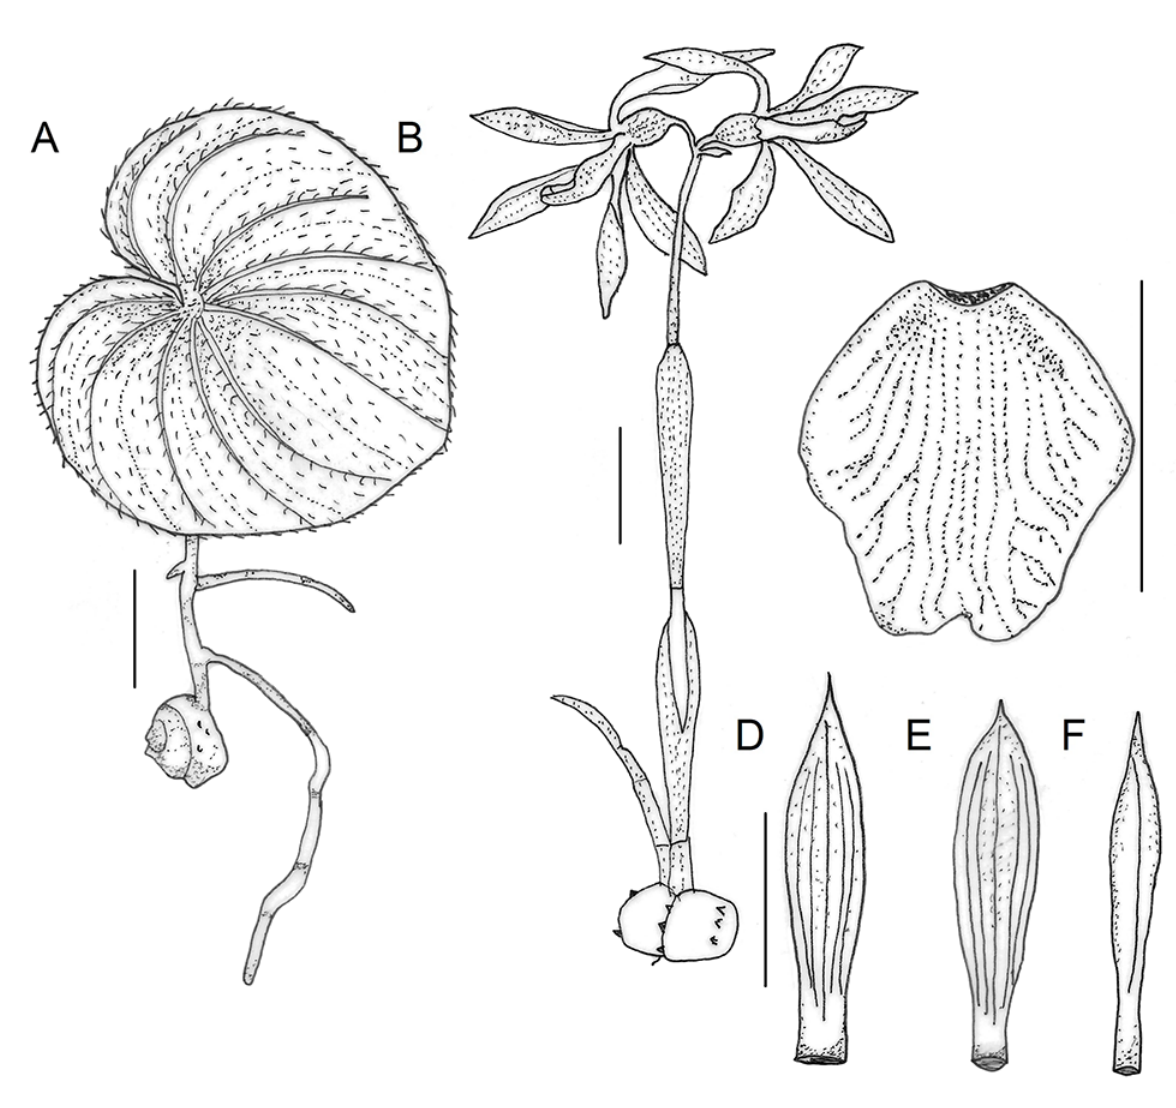
Figure 5 Nervilia plicata . ( A ) Habit in the leafy stage. ( B ) Inflorescence. ( C ) Lip. ( D ) Dorsal sepal. ( E ) Lateral sepal. ( F ) Petal. Scale bars: 2 cm ( A,B ); 1 cm ( C ); 5 mm ( D–F ). Drawn by M. Lipińska.